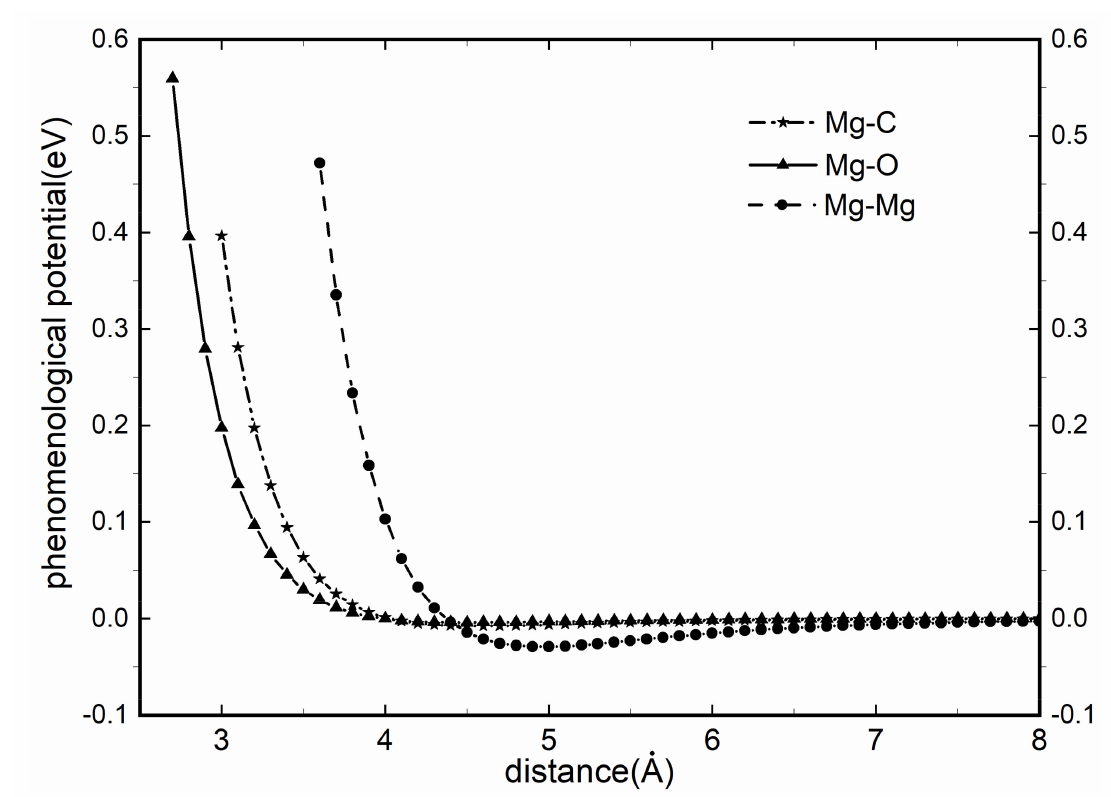
Figure 3. Reduced phenomenological potential for neutral-neutral interaction ( m = 6).